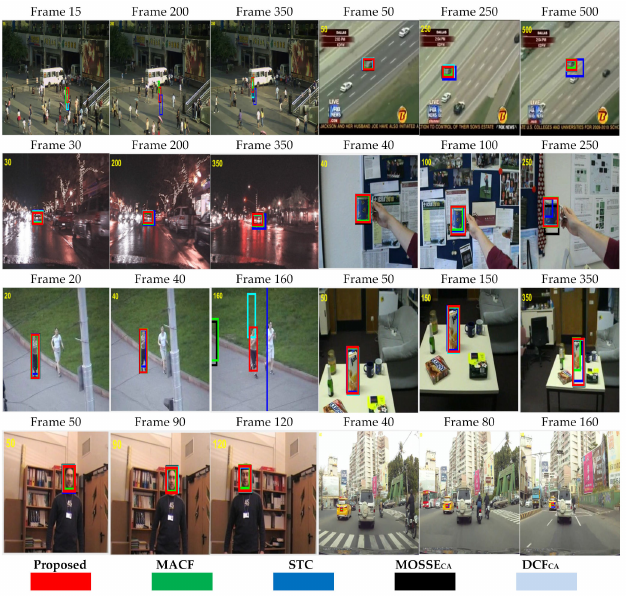
Figure 5. Qualitative comparison of proposed with four state-of-the-art trackers on selected image sequences taken from TC-128, OTB2013 and OTB2015